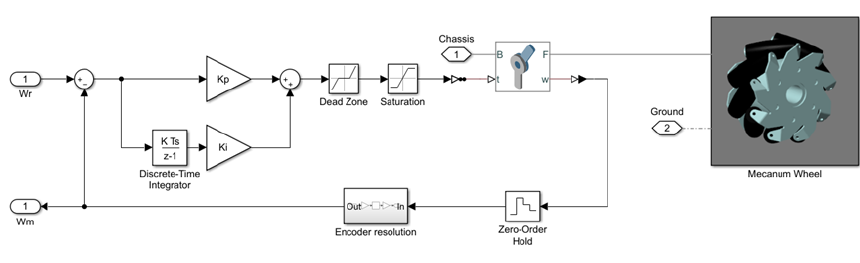
Figure 7. PI controller with the revolute joint as motor attached to a mecanum wheel.